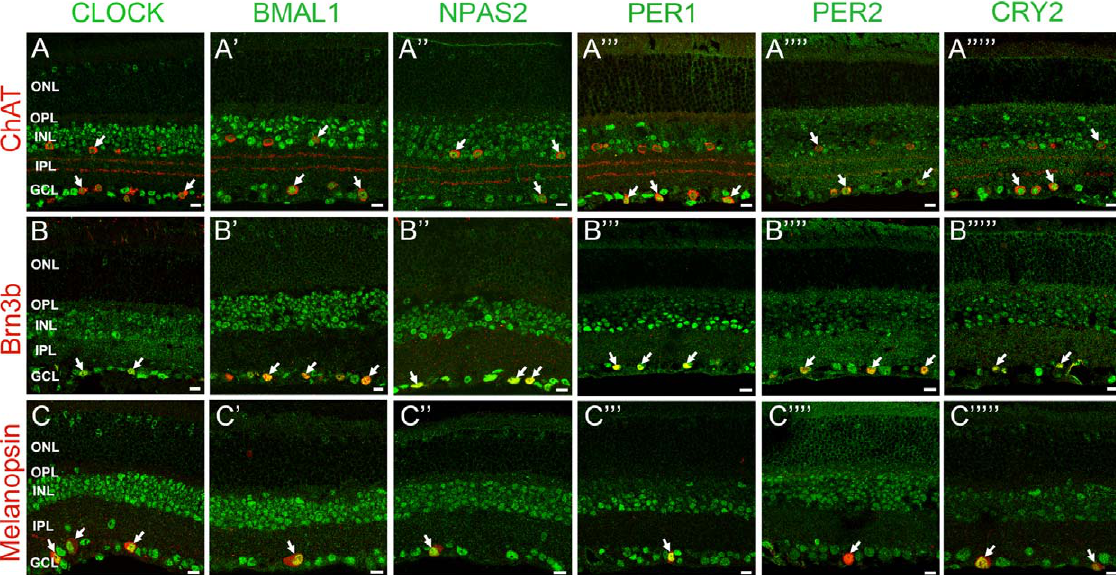
Figure 5. Mammalian core circadian clock protein expression in amacrine and ganglion cells of the mouse retina. Typical examples of vertical sections of mouse retinas collected between ZT02 and ZT06 and double labeled for one of the following clock proteins: CLOCK ( A–C ), BMAL1 ( A’–C’ ), NPAS2 ( A’’–C’’ ), PER1 ( A’’’–C’’’ ), PER2 ( A’’’’–C’’’’ ), and CRY2 ( A’’’’’–C’’’’’ ) and one of the following protein markers: ChAT (starburst amacrine cells; A ), Brn3b (most ganglion cells; B ), and eGFP (ipRGCs; C ) (see Table 1 for details about the antibodies). The concurrent expression of CLOCK, BMAL1, NPAS2, PER1, PER2, and CRY2 was found in all identified neurons. Note also that all the clock proteins are expressed in the ON starburst amacrine cells whose cell body is located in the ganglion cell layer (GCL), indicating that both GCs and displaced amacrine cells in the GCL express the core components of the mammalian clock. Clock protein expression in ipRGCs was confirmed with the AB-N38 antibody (data not illustrated), although this antibody only labeled M1 and M2 ipRGC subtypes. Some double-labeled retinal neurons are shown (arrows). Abbreviations and bar as in Fig. 3.